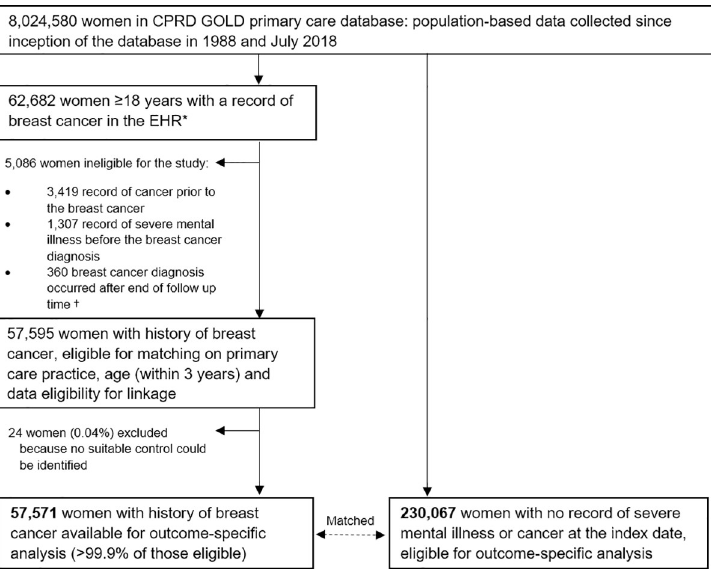
Fig 1. Flowchart of the selection of the cohorts used in analyses. CPRD, Clinical Practice Research Datalink; EHR, electronic health record. � Women with research quality follow-up, as defined by CPRD based on systematic checks for data quality at both patient and practice level. † Almost all had a first record of breast cancer a few days after the recorded date of death.